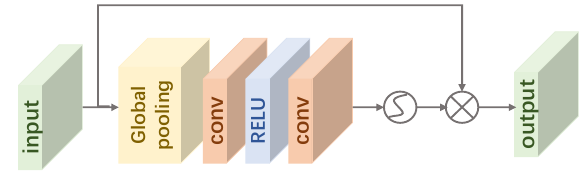
Figure 7. The structure of channel attention mechanism